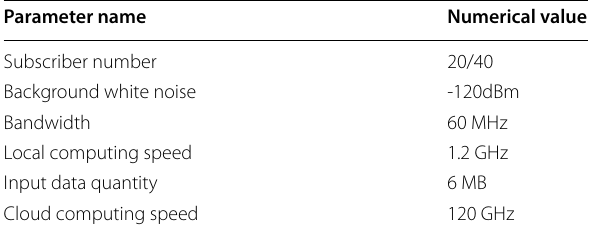
Table 1 Experimental parameters